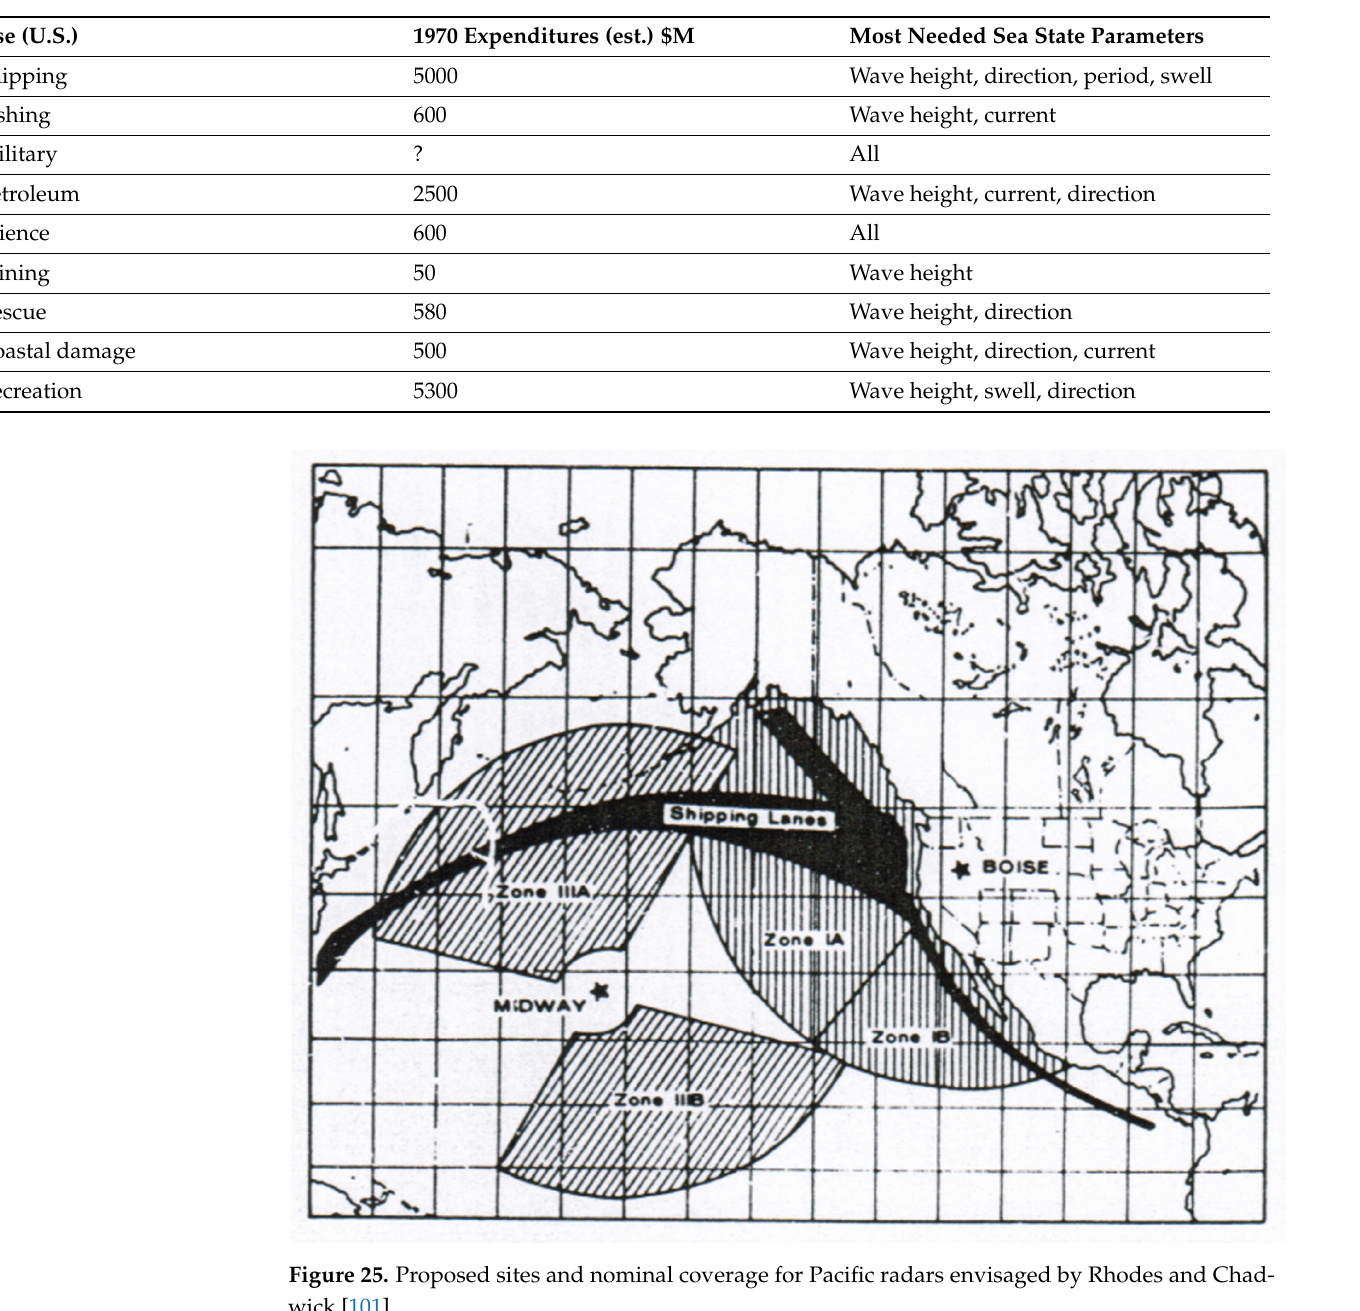
Table 2. Summary of sea state users and needs (from [101]).